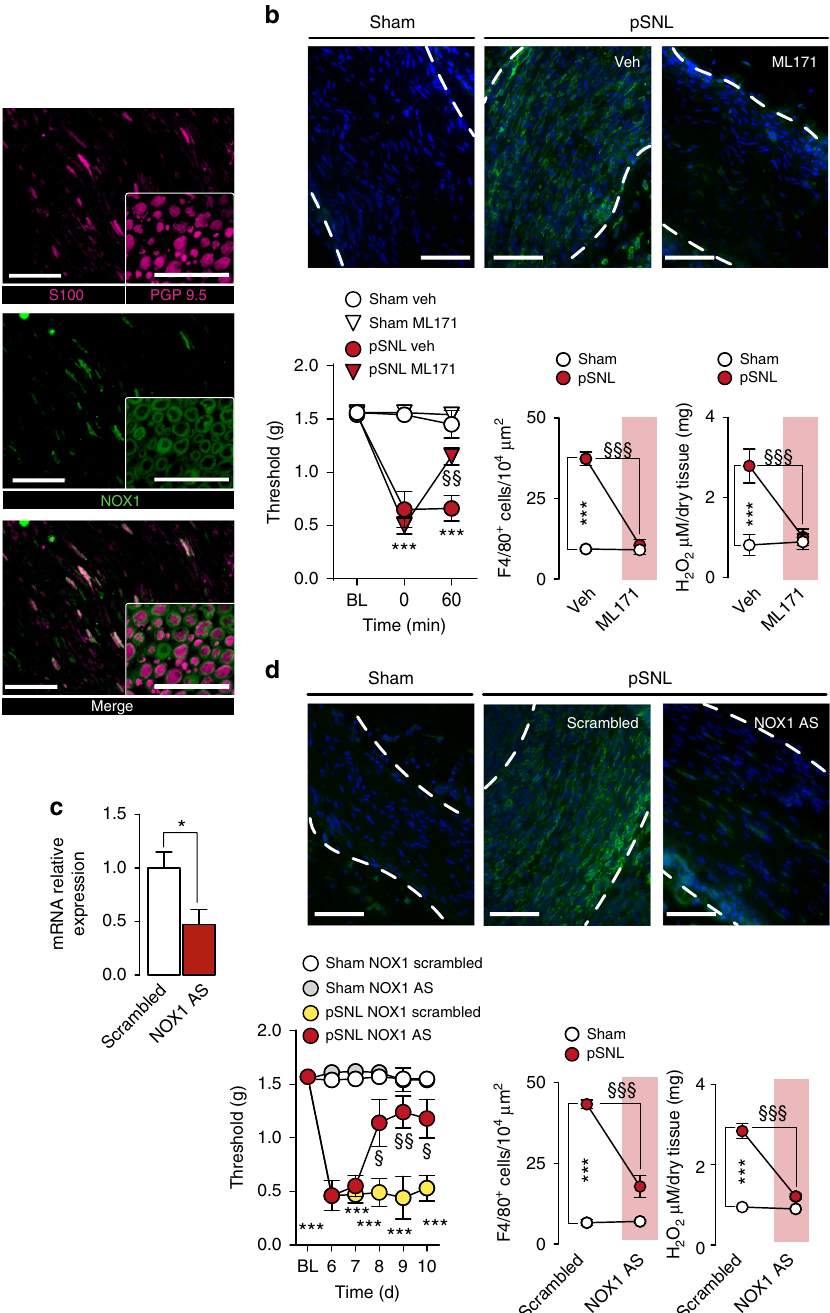
Fig. 5 NOX1 blockade inhibited pSNL-evoked allodynia and neuroin fl ammation. a Images of S100/PGP9.5 and NOX1 immuno fl uorescence in sciatic nerves (Scale bars: 50 μ m and inset 20 μ m). b Mechanical allodynia, representative images and F4/80 + cell number, and H 2 O 2 content (at day 10 after surgery) in sham/pSNL mice after NOX1-inhibitor (ML171, 60 mg kg − 1 , i.p) or vehicle (veh, 4% DMSO and 4% tween 80 in isotonic saline) ( n = 6, *** P < 0.001 pSNL- veh vs. sham-veh; §§ P < 0.01 and §§§ P < 0.001 pSNL-ML171 vs. pSNL-veh; two-way ANOVA followed by Bonferroni post hoc analyses) (Scale bars: 50 μ m; dashed lines, perineurium). c NOX1 mRNA relative expression in sciatic nerve after perineural NOX1 antisense oligonucleotides (AS-ODN) or scrambled- ODN (both, 10 nmol 10 µ l − 1 ) ( n = 3 replicates from two independent experiments, * P < 0.05 AS-ODN vs. scrambled-ODN; unpaired two-tailed Student ’ s t- test). d Mechanical allodynia, representative images and F4/80 + cell number, and H 2 O 2 content (at day 10 after surgery) in sham/pSNL mice after NOX1 AS-ODN or scrambled-ODN (both, 10 nmol 10 µ l − 1 ) ( n = 6, *** P < 0.001 pSNL-NOX1-scrambled vs. sham-NOX1scrambled; § P < 0.05, §§ P < 0.01 and §§§ P < 0.001 pSNL-NOX1 AS-ODN vs. pSNL-NOX1scrambled; two-way ANOVA followed by Bonferroni post hoc analyses) (Scale bars: 50 μ m; dashed lines, perineurium). Data are represented as mean ±